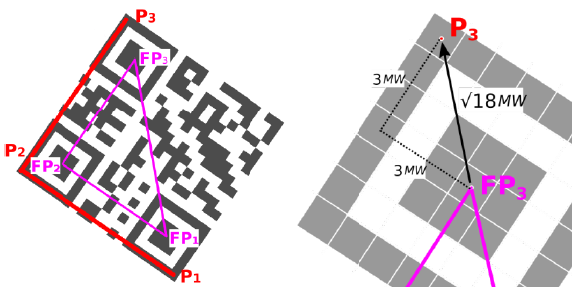
Figure 12. Bounding Box.